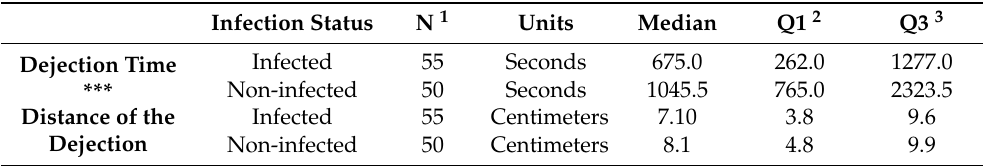
Table 2. Summary values of the defecation activity according to Trypanosoma cruzi infection status of Triatoma infestans .